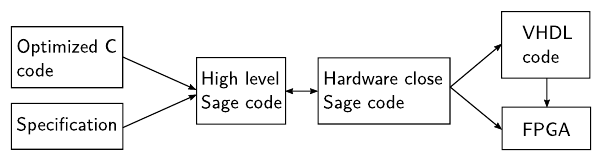
Figure 16: How the testing and coding was done for VHDL.